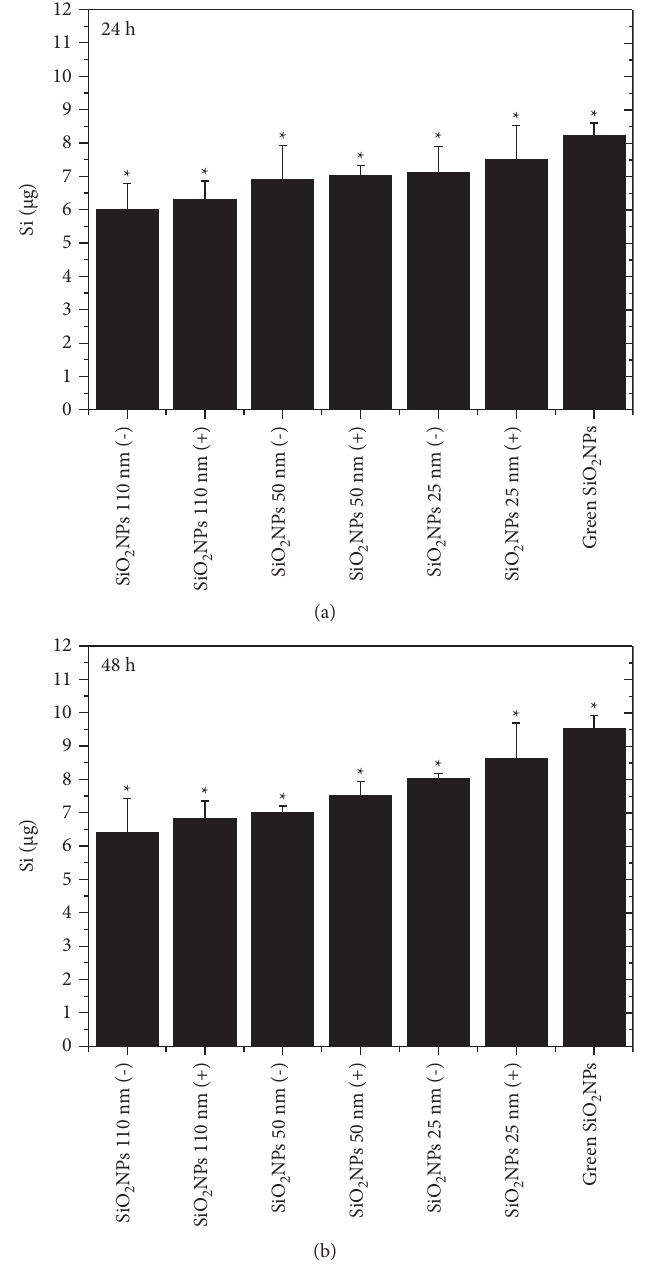
Figure 8: Elemental analysis performed in A549cell lines exposed to 5mg/mL of SiO 50nm ( − ), SiO 2 NPs 50nm (+), SiO 2 NPs 25nm ( − ), SiO 2 NPs 25nm (+), and green SiO 2 NPs. Cells were then harvested and counted, and Si content was measured in 360.000 cells ( μ g Si). Histograms reported the silicon amount. Data were reported as mean ± SD from three independent experiments: statistical significance of exposed cells versus control cells (0 ug) for p value < 0.05 ( < 0.05 ∗